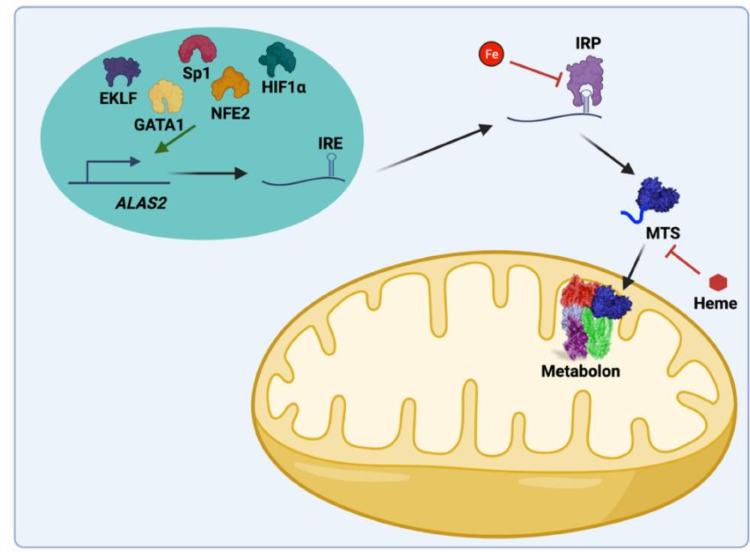
Figure 3. Key regulatory features of mammalian ALAS-2 synthesis, stability, and activity. ALAS2 transcription is regulated by GATA1, NfE2, EKLF, Sp1, and HIF1 α . ALAS2 mRNA possesses an iron-responsive element (IRE) that is bound by iron-responsive protein (IRP) in the absence of iron inhibiting translation. Additionally, heme can regulate the import into the mitochondria. In the mitochondria, the ALAS2 protein is regulated by the mitochondrial heme metabolon, which includes ALAS2, FECH, PPOX, SCS, and KDH. Created with